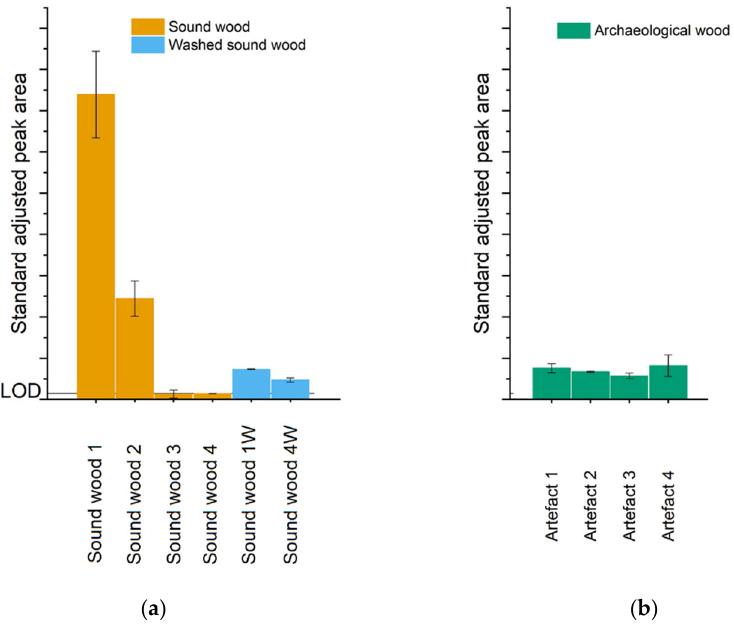
Figure 2. Acetic acid peak areas detected by SPME GC–MS analysis for sound wood and washed sound wood ( a ) and archaeological wood ( b